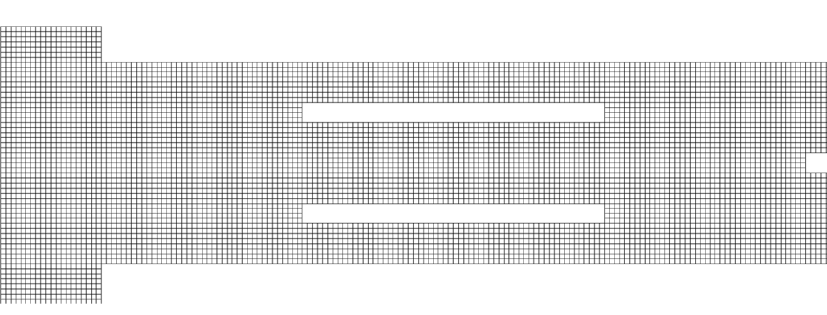
Figure 2. Grid of T-mixer with